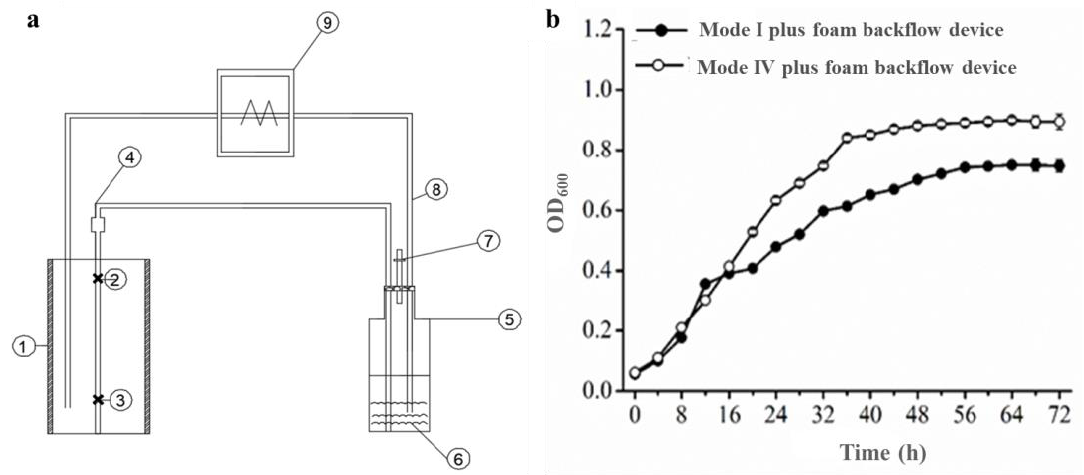
Figure 4. Effect of foam backflow device on the fermentation of S. pararoseus JD-2. ( a ) Foam backflow device. 1 (cid:13) Fermenter, 2 (cid:13) Antifoaming paddle, 3 (cid:13) Stirring paddle, 4 (cid:13) Exhaust pipe, 5 (cid:13) Collection bottle, 6 (cid:13) Solution without foams, 7 (cid:13) Off-gases, 8 (cid:13) Feeding pipe, 9 (cid:13) Peristaltic pump. ( b ) Effect of foam backflow device on cell growth of S. pararoseus JD-2. The data represent mean values and standard deviations obtained from three independent cultivations. 300 Table 3. Effect of foam return device on the fermentation of S. pararoseus JD-2 301 Feeding mode